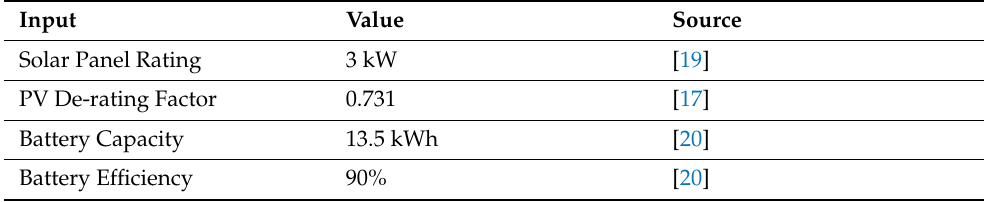
Table 1. Photovoltaic (PV) and Energy Storage System (ESS) performance parameters.